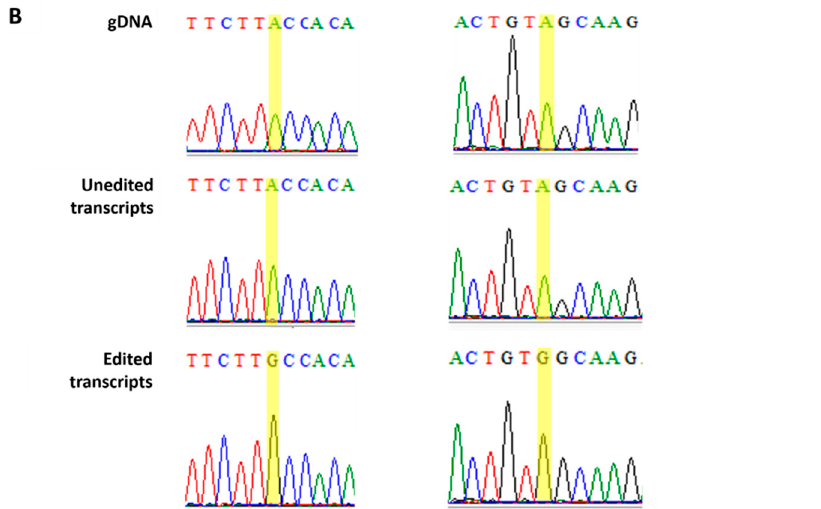
Figure 4. Naïve and acute EAE murine microglia displayed different frequencies of ADAR-mediated (A-I-G) RNA editing within the 3 ′ UTR of the Mpeg1 transcript (increased editing frequency in disease condition); a similar Mpeg1 -3 ′ UTR differential editing frequency pattern was detected in brain tissue. ( A ). Experimental validation of A-I-G editing events, based on the direct comparison of cDNAs with corresponding gDNA sequences through Sanger sequencing. Three technical replicates of brain microglia samples were used per condition (EAE, Cntr); editing frequencies were calculated from corresponding Sanger sequencing chromatograms of PCR-amplified cDNAs encompassing part of the target 3 (cid:48) UTR flanking the predicted editing sites. ImageJ was used to calculate editing frequencies as the percentage of G peaks, relative to A peaks, per editing site. Brain tissue analysis was performed on three biological replicates per condition ( n = 3 EAE, n = 3 Cntr), including the analysis of at least 30 clones per sample. For editing frequency quantification, the percentage (%) of cDNA clones displaying the edited base, relative to the total number of tested clones, per sample was measured. Bars indicate the mean editing frequency per sample type and condition. Error bars correspond to standard error. For statistical analyses, one-tailed unpaired t-test was performed. Significance symbols are as follows: * p ≤ 0.05, ** p ≤ 0.01. ( B ). Representative chromatograms from